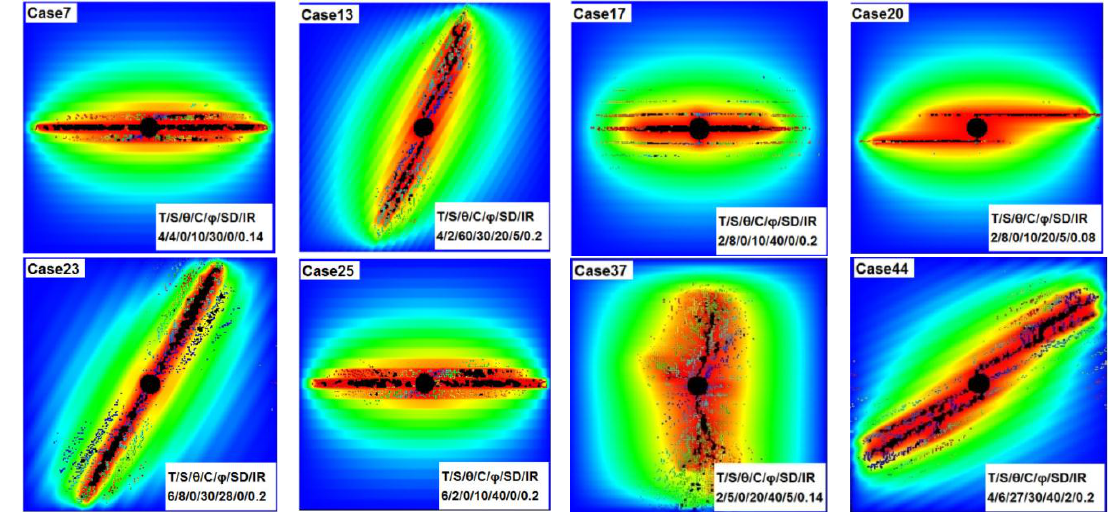
Figure 4. The hydraulic fracturing simulation results for the partial 8 run cases according to Table 3.